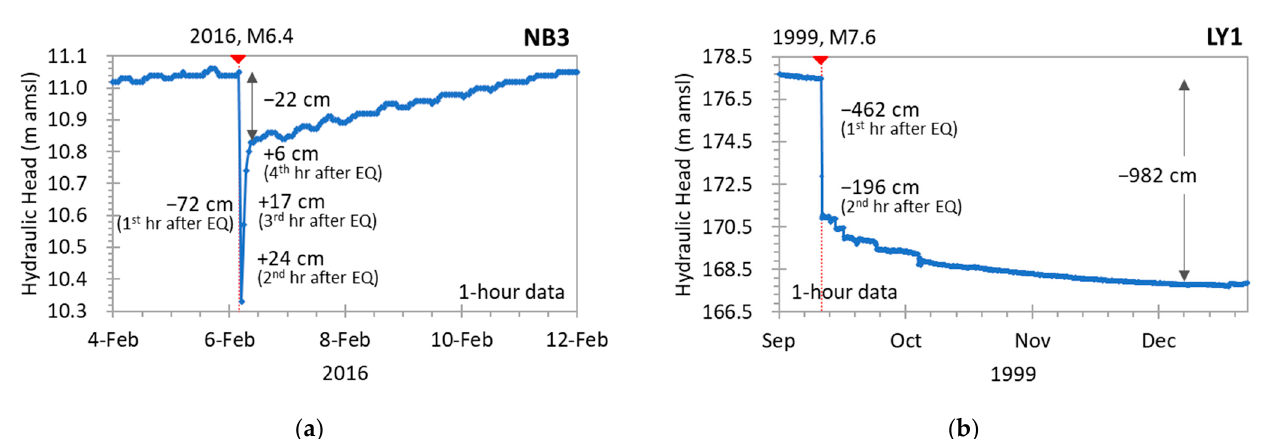
Figure 6. Abnormal post-seismic changes in groundwater level: ( a ) post-seismic changes after a coseismic fall of 72 cm in well NB3 due to the 2016 M6.4 earthquake; ( b ) post-seismic changes after a coseismic fall of 658 cm in well LY1 due to the 1999 M7.6 earthquake.